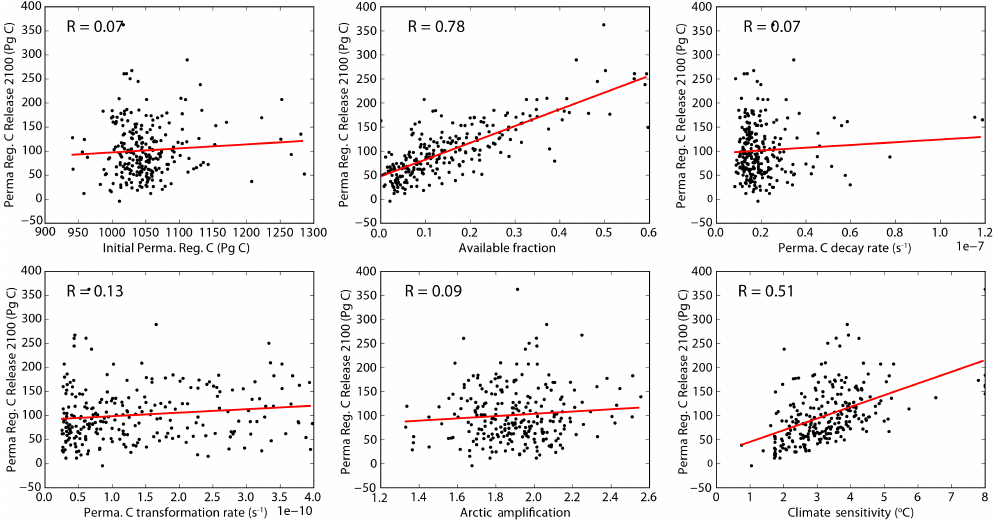
Figure 6. Correlation between release of carbon from the permafrost region in year 2100 under RCP 8.5 and value of perturbed model parameters. Red line is line of best fit and R is correlation